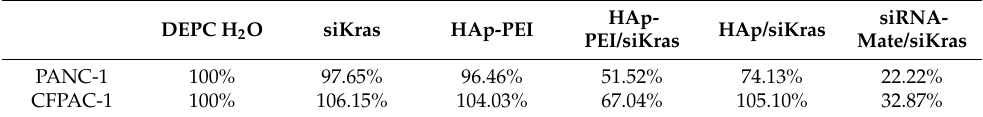
Table 2. Relative quantification of Kras protein expression. Figure 8. Expression of Kras protein in ( a ) PANC-1 and ( b ) CFPAC-1 cells after siKras transfection for 48 h by HAp-PEI, Hap, and siRNA-Mate. DECP H 2 O, siKras and HAp-PEI treatment were used as control.